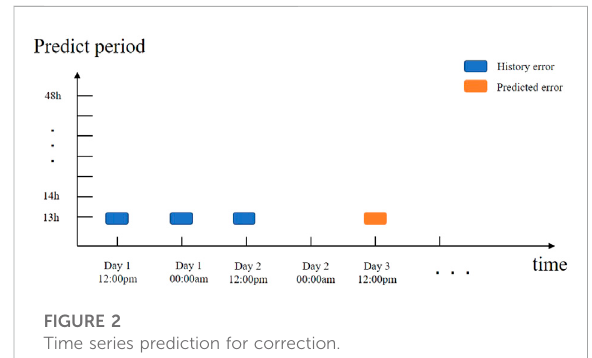
FIGURE 2 Time series prediction for